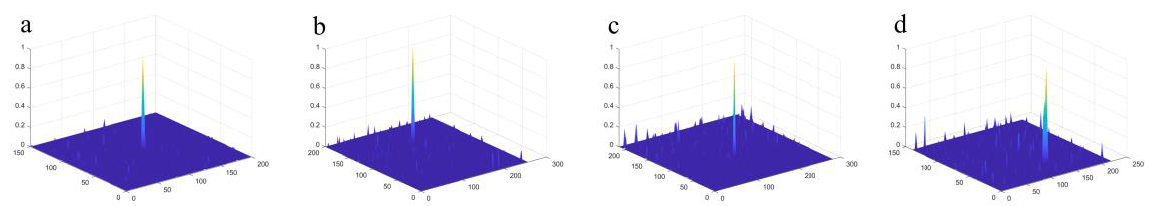
Figure 8. Three-dimensional views of the improved Top-hat operation results: ( a ) sky, ( b ) cloud, ( c ) land, and ( d ) sea.